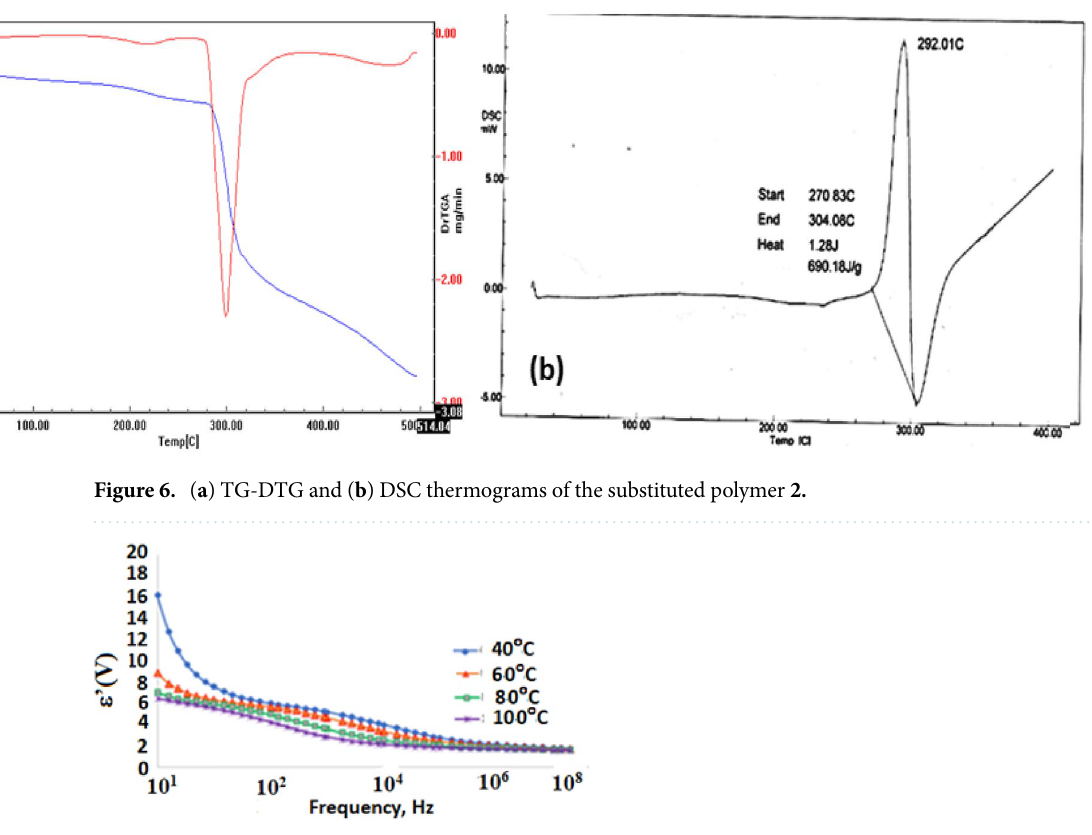
Figure 7. Effect of temperature on permittivity at different frequency for the polymer